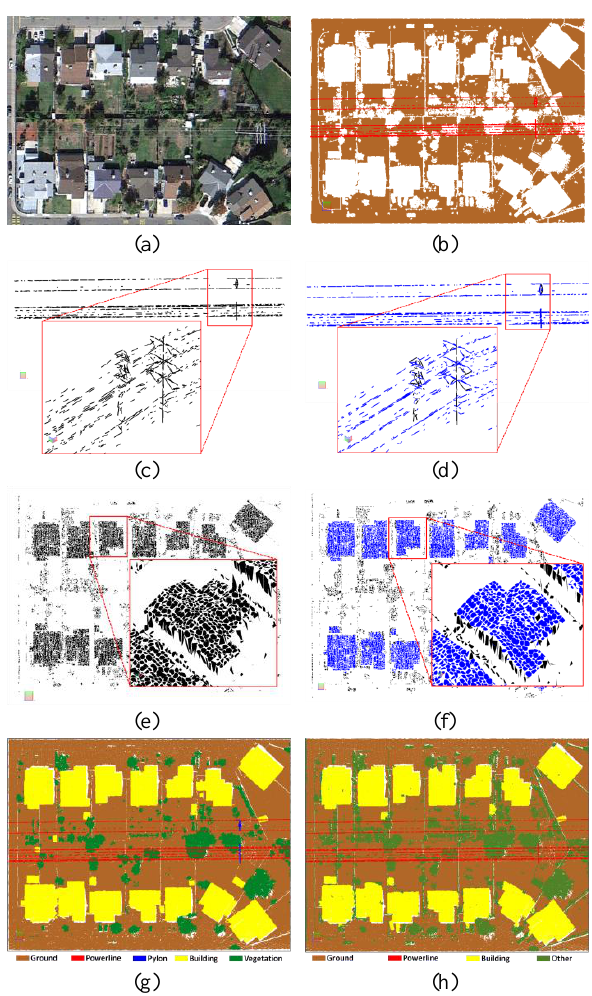
Figure 2. PL scene classification; (a) optical image, (b) linear feature extraction (red), (c) line segments, (d) PL (blue) vs. non- PL (black), (e) plane segments, (f) building (blue) vs. non- building (black), (g) ground truth, and (h) PL scene classification result.